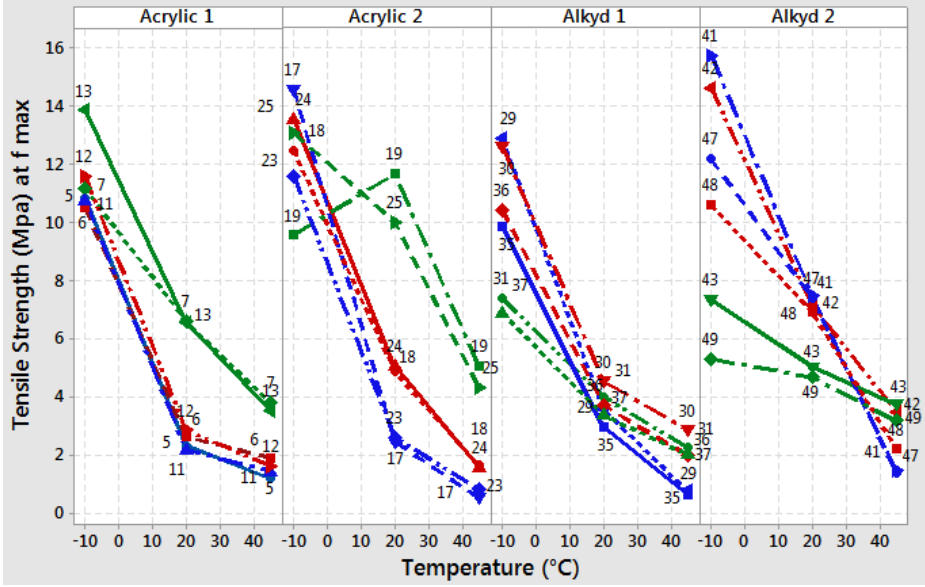
Figure 6. Influence of coating formulation on tensile strength for the three test temperatures (in blue: clear PVC; in red: low PVC; in green: high PVC).